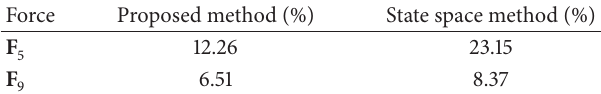
Table 1: Cantilever beam properties.